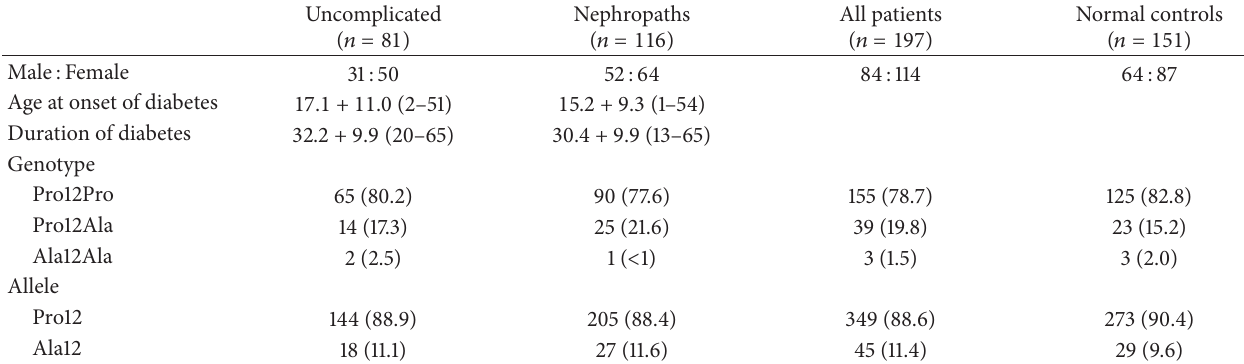
Table 1: Clinical characteristics and frequencies (%) of polymorphism of the PPAR 𝛾 2 gene in patients with type 1 diabetes and normal controls.